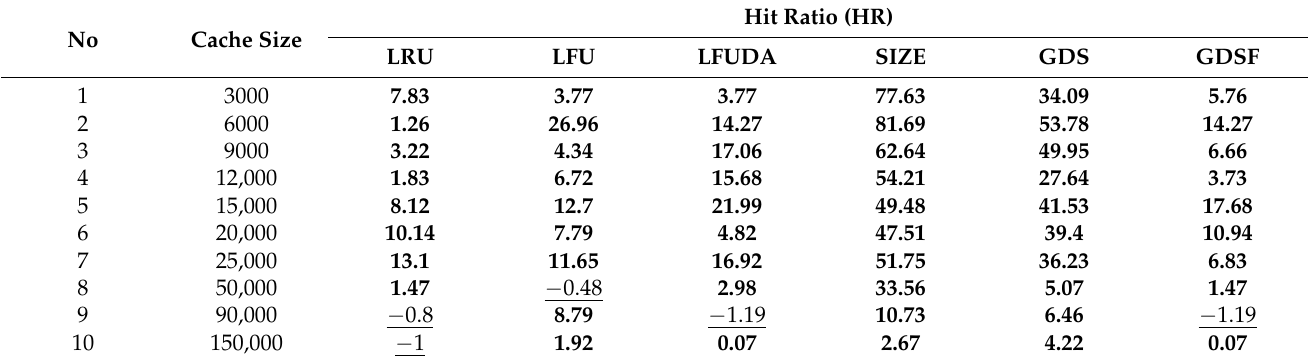
Table 4. Improvement ratio by LRU-GENACO for the six caching